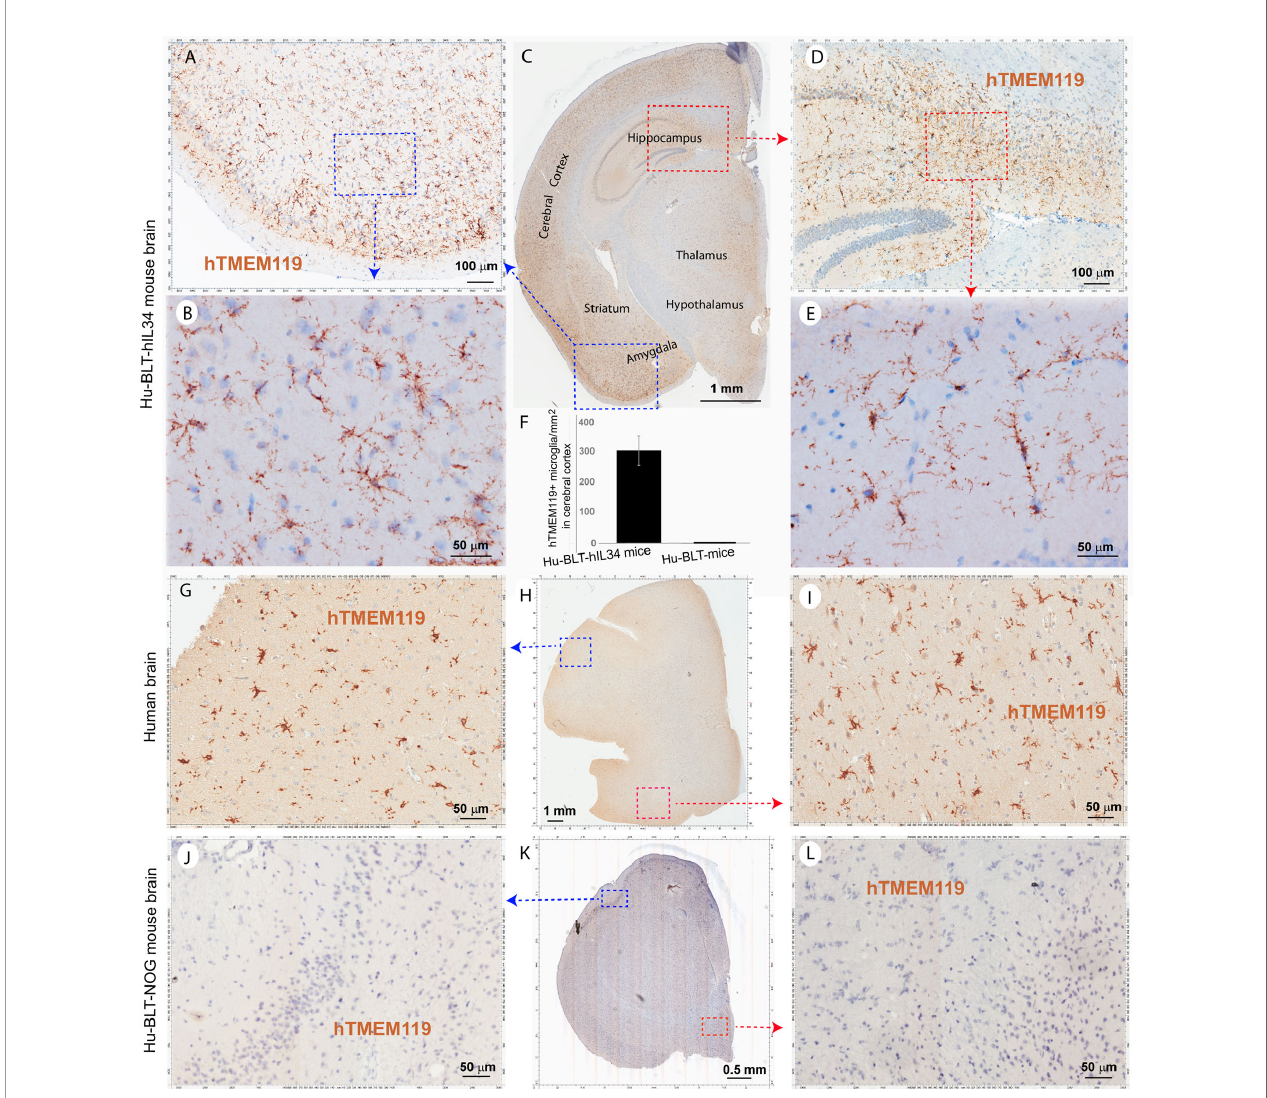
FIGURE 4 | The microglia-speci fi c marker hTMEM119+ microglia in the brain tissues of hu-BLT-hIL34 and hu-BLT mice and humans. A representative whole brain tissue section (C) from the third coronal brain slice of a hu-BLT-hIL34 mouse (#1703) that was stained immunohistochemically for hTMEM119+ cells (brown) and counterstained with hematoxylin. LV stands for lateral ventricle. The blue and red boxed regions in the Figure (C) were highlighted at a higher magni fi cation (A, D) . In turn, the blue and red boxed regions of the Figures (A, D) were highlighted (B, E) . The hTMEME119+ cells (brown) are morphologically rami fi ed and distributed in brain parenchyma. The histogram of quantitative images analysis of hTMEM119 + cells in the cerebral cortex of the hu-BTL-hIL34 mice (F) (304.08 ± 131.93 hTEME119+ cells/mm2, n=6), where there were an absent of these cells in the hu-BLT mice. The middle panel (G – I) shows hTMEM119 + microglia in the cerebral cortex of a HIV-1 non-infected individual with no registered medical complications (G – I) . The frequency, distribution, and morphology of hTMEM119+ human microglia in hu-BLT-hIL34 mice are similar to this human individual. The lower panel (J – L) shows no detectable hTMEM119+ cells in a representative whole brain section of a hu-BLT mouse